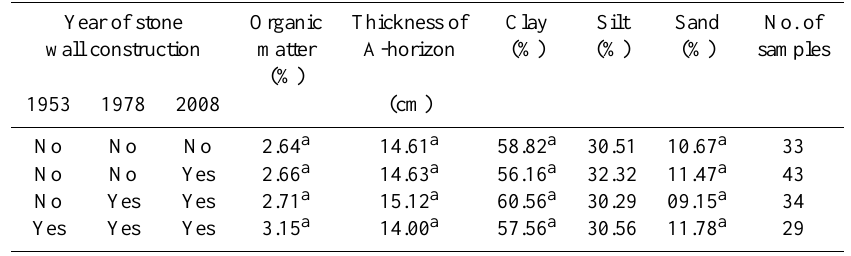
Table 4. Soil properties for soil according to the year of stone wall construction. Year of stone Organic Thickness of Clay wall construction matter